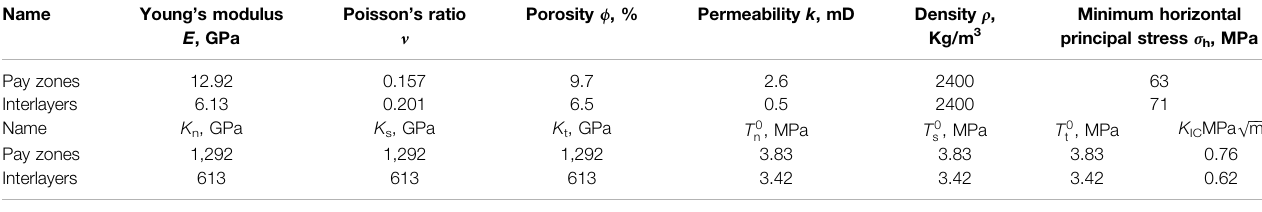
TABLE 1 | Basic parameters of pay zones and interlayers.